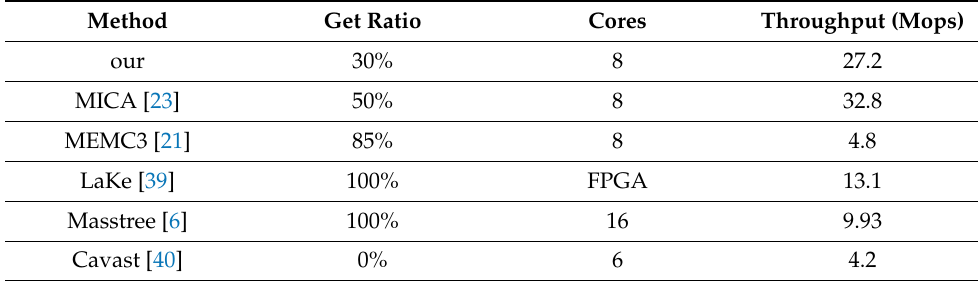
Table 2. The throughput of our caching system relative to other memory caching